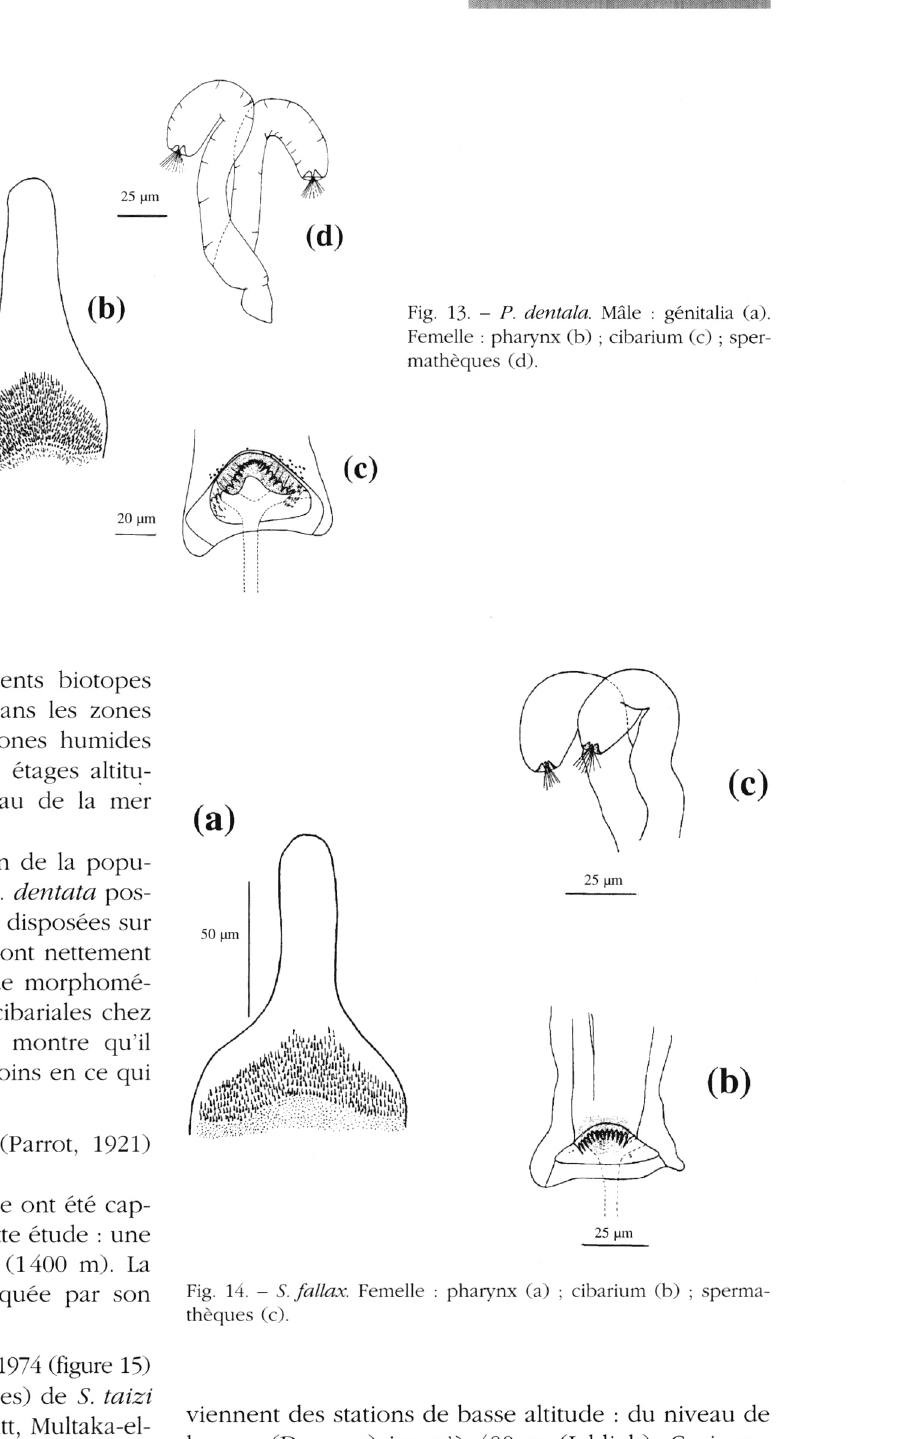
viennent des stations de basse altitude : du niveau de la mer (Damour) jusqu’à 400 m (Jahlieh). Ceci cor­ respond essentiellement à l’étage thermo-méditerra- néen, relativement humide et chaud peuplé par les séries du caroubier-lentisque et du Quercus